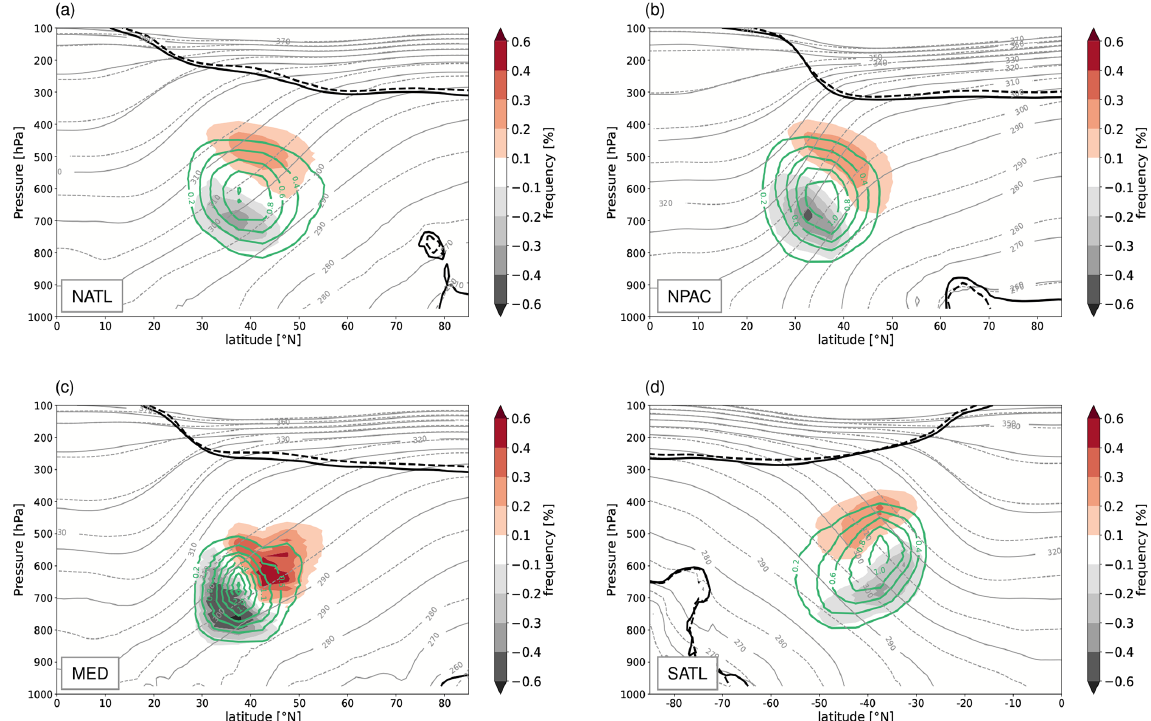
Figure 12. The 50-year mean potential temperature (grey lines) and potential vorticity (2pvu isolines; black lines), zonally averaged over the four target regions (a) NATL, (b) NPAC, (c) MED, and (d) SATL. Dashed lines correspond to RCP8.5 and solid lines to HIST. Solid green lines show the normalized frequency (bin size 5 ◦ , 25hPa) distribution of the WCB air parcels during the time of maximum diabatic heating for HIST (outermost line for 0.2% with an increment of 0.2% for NATL, NPAC, and SATL and 0.3% for MED). The climate change effect of the distribution of maximum latent heating, RCP8.5 − HIST, is shown in colour shading. All panels are for winter in the corresponding hemisphere, i.e. DJF in (a) – (c) and JJA in (d) , and the PV has been multiplied by − 1 in